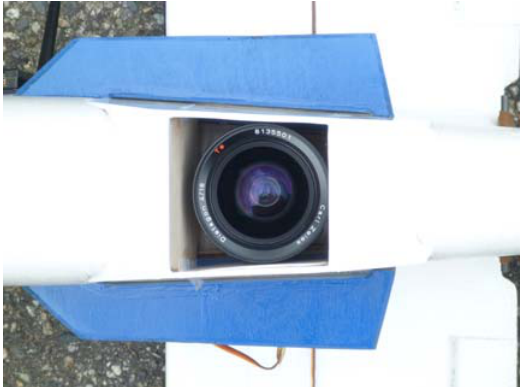
Figure 3. UAV Payload – Samsung NX1000 with Carl